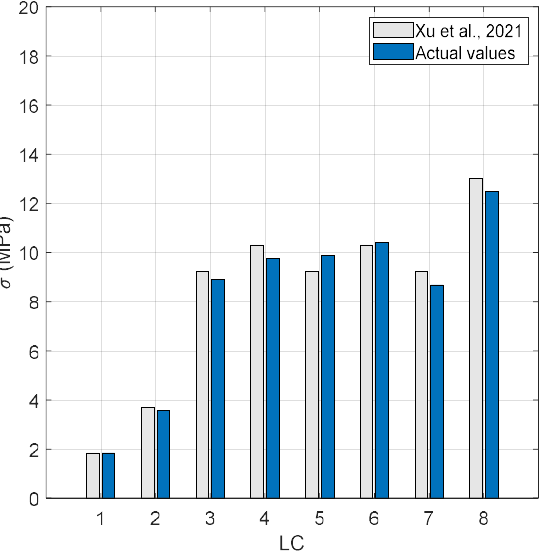
Figure 5. Comparative analysis—standard deviation of stress history in line #1.